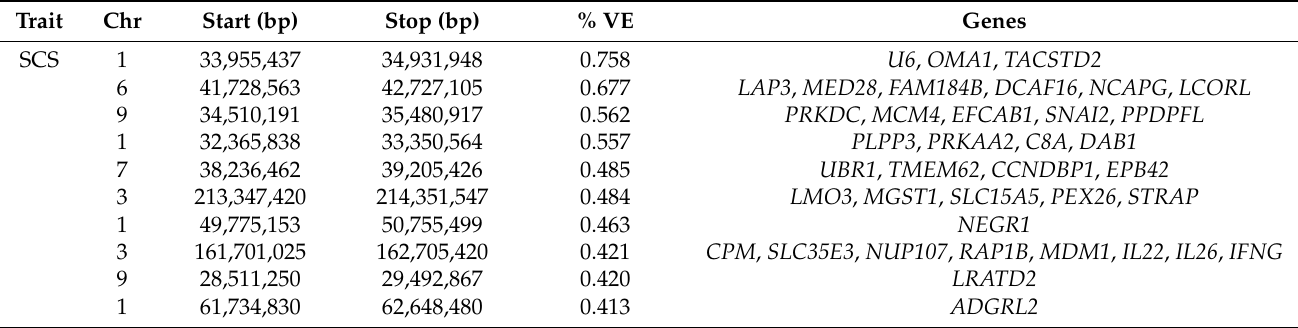
Table 5. Identification of genes based on additive genetic variance explained by top 10 window regions for